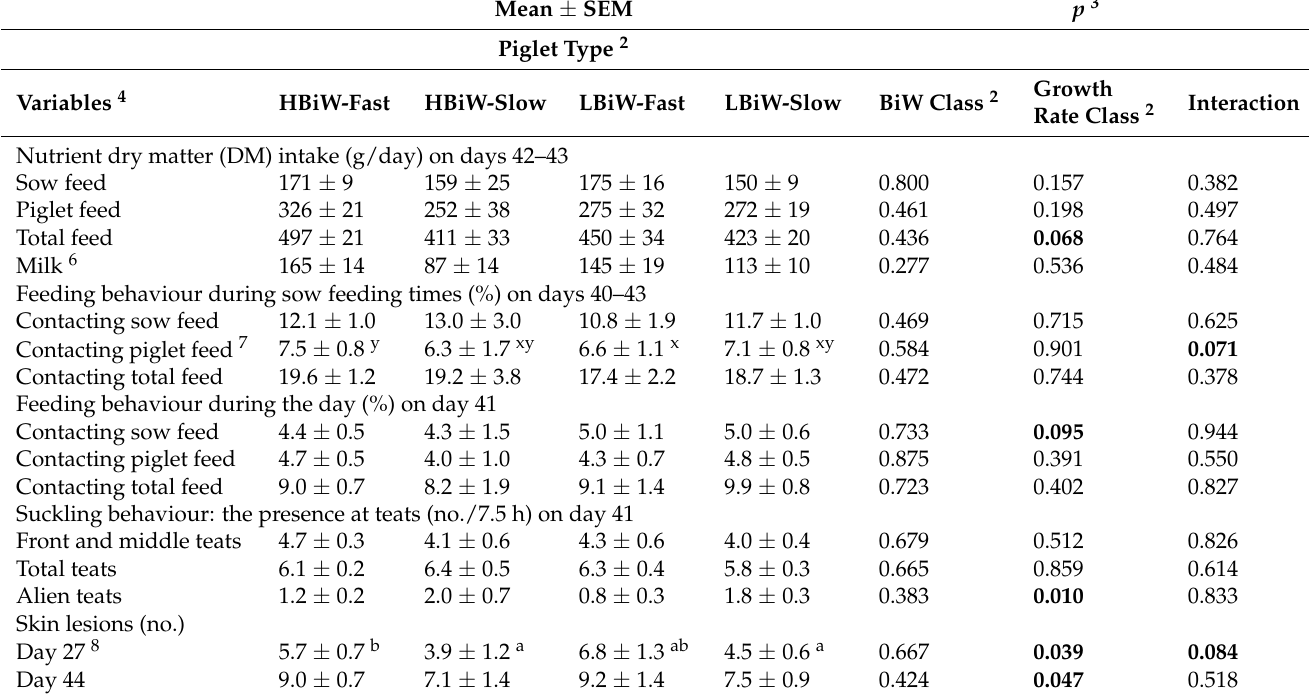
Table 2. Cont. Mean ± SEM p 3 Piglet Type